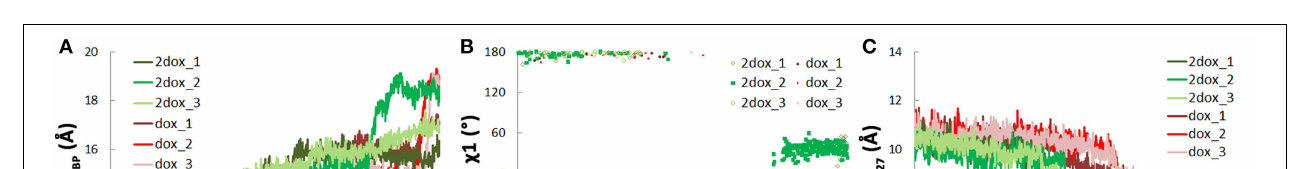
FIGURE 3 | The second substrate binding at A monomer accelerates the conformational changes of B monomer. (A) Top view of the porter domains with two doxorubicins (yellow and orange) bound in the initial structure of the 2dox system. The distance between doxorubicin and DBP in A monomer is indicated as D A DOX − DBP . (B) Comparison of the variations of